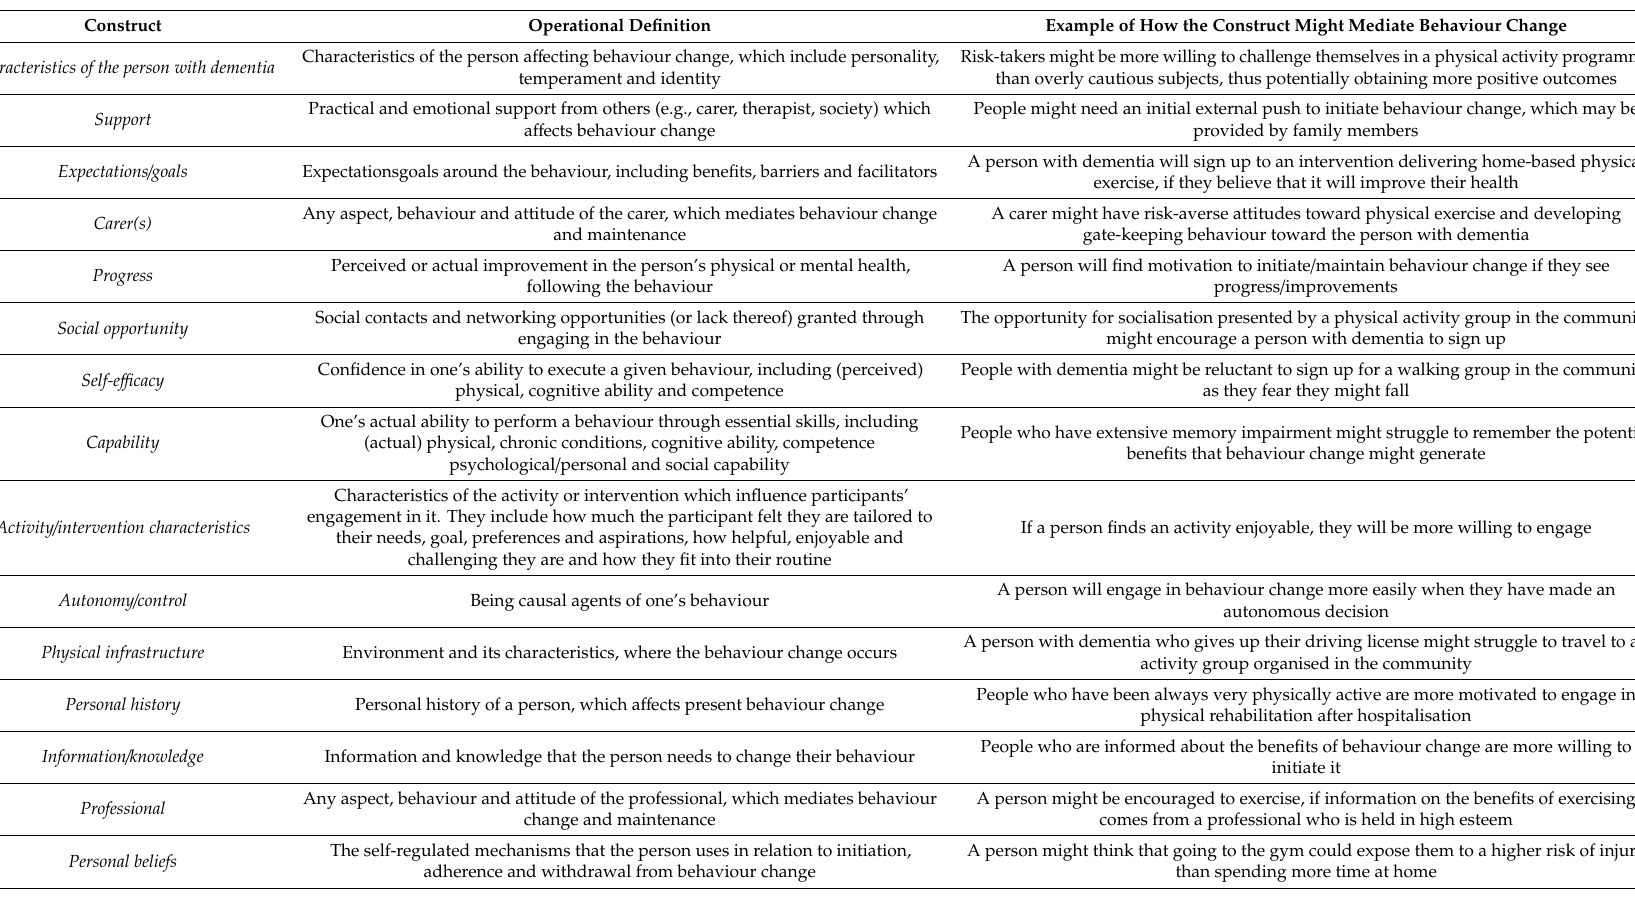
Table 2. Operational definitions of the constructs and examples of how they mediate behaviour